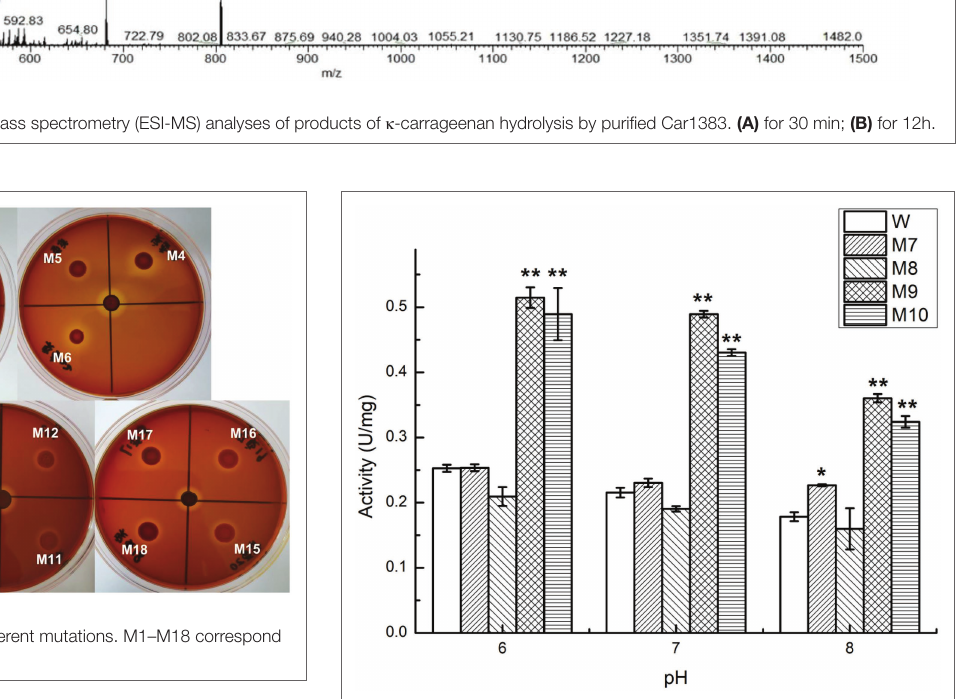
FIGURE 9 | Comparison of enzyme activity of Car1383 and its variants at pH 6.0–8.0. * p < 0.05, ** p <